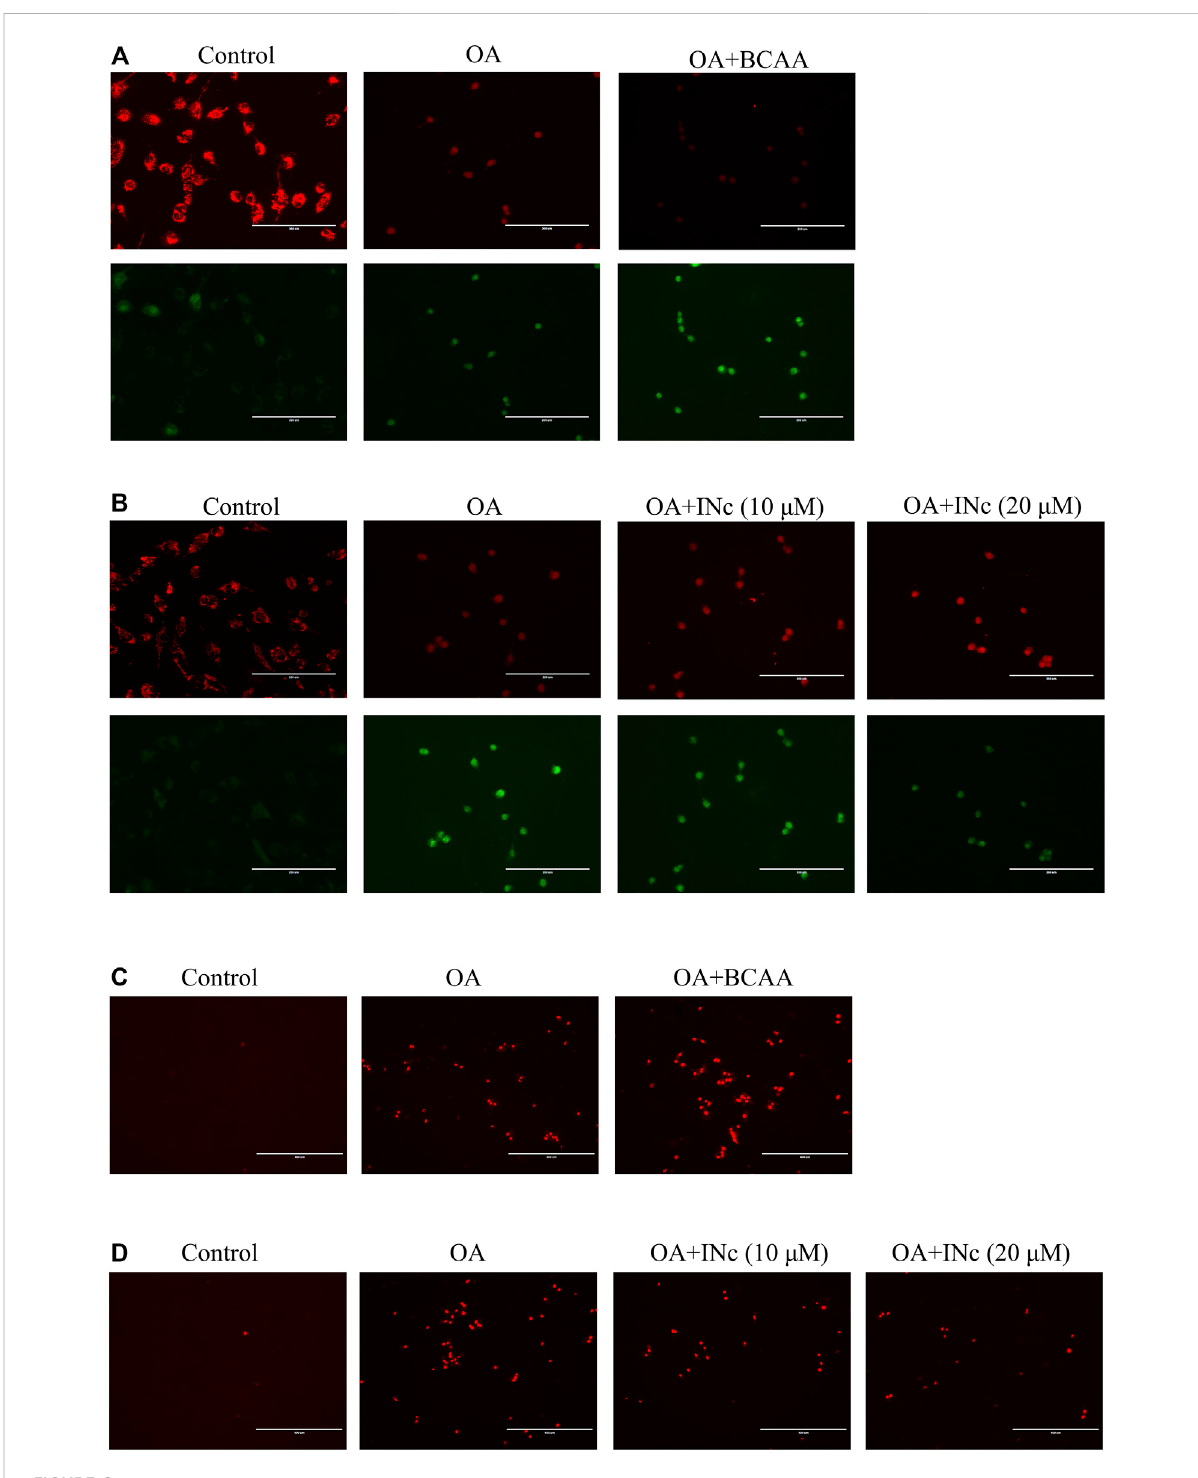
BCATc inhibitor 2 alleviates OA-induced mitochondrial membrane potential disruption and intracellular ROS production. (A,B) LO2 cells were incubated with 0.5 mm Oleic acid with or without 10 mm BCAAs or BCATc Inhibitor 2 for 48 h. Mitochondrial membrane potential was determined byJC-1staining.Scalebar=200 µM. (C-D) LO2cellswereincubatedwith 0.5 mmOleicacidwith orwithout 10 mmBCAAsorBCATc Inhibitor2for 48 h. Mitochondrial ROS level was detected by MitoSOX staining. INc: BCATc Inhibitor